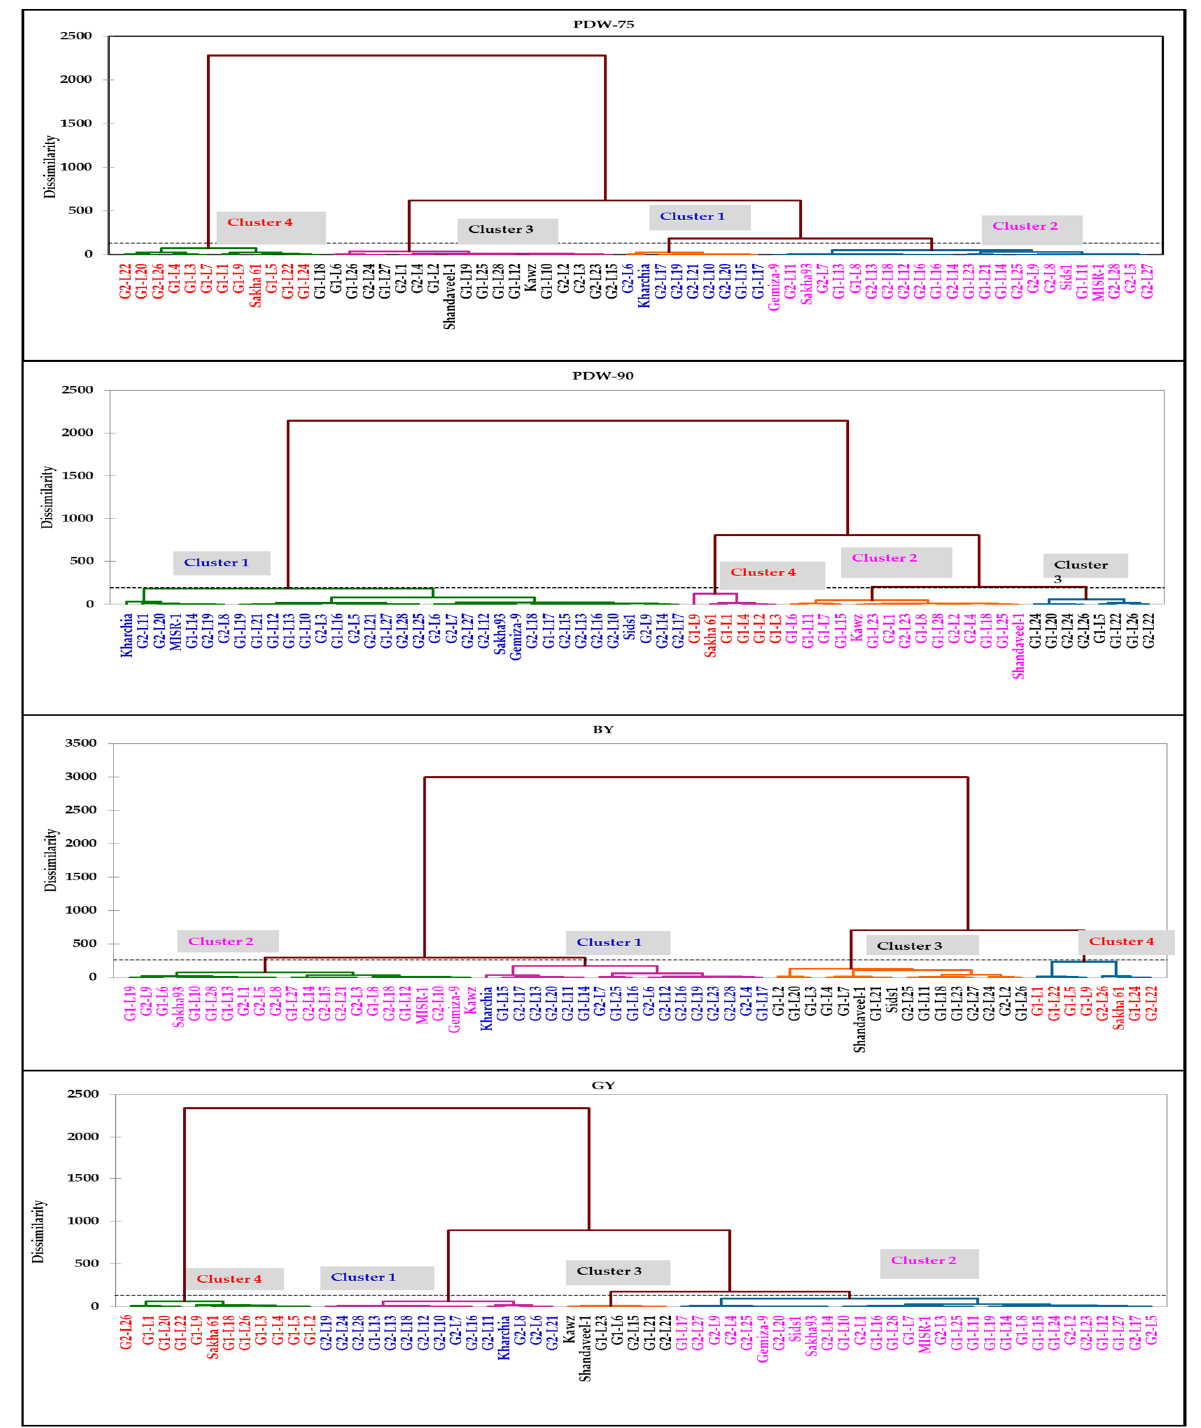
Figure 5. Hierarchical clustering derived by Ward’s methods of cluster analysis for plant dry weight measured at 75 (PDW ‐ 75) and 90 (PDW ‐ 90) days after sowing, biological yield (BY), grain yield (GY) and their different stress tolerance indices of 64 wheat genotypes grown under the control and salinity stress conditions. PDW ‐ 75, PDW ‐ 90, BY, and GY indicate plant dry weight measured at 75 (PDW ‐ 75) and 90 (PDW ‐ 90) days after sowing, biological yield (BY), and grain yield (GY), respectively. The full names of the different STIs are listed in Table 1.